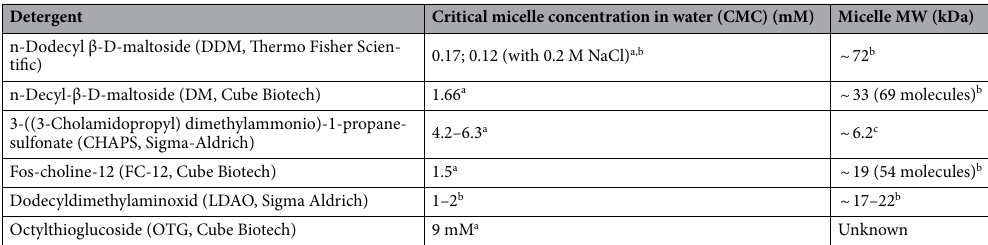
Table 5. Detergents used for membrane solubilisation, including their abbreviations as used in the following, as well as suppliers. References of the CMC-values and the micelle MW. a cube-biotech.com. b https:// www. anatr ace. com/. c https:// www. sigma aldri ch.